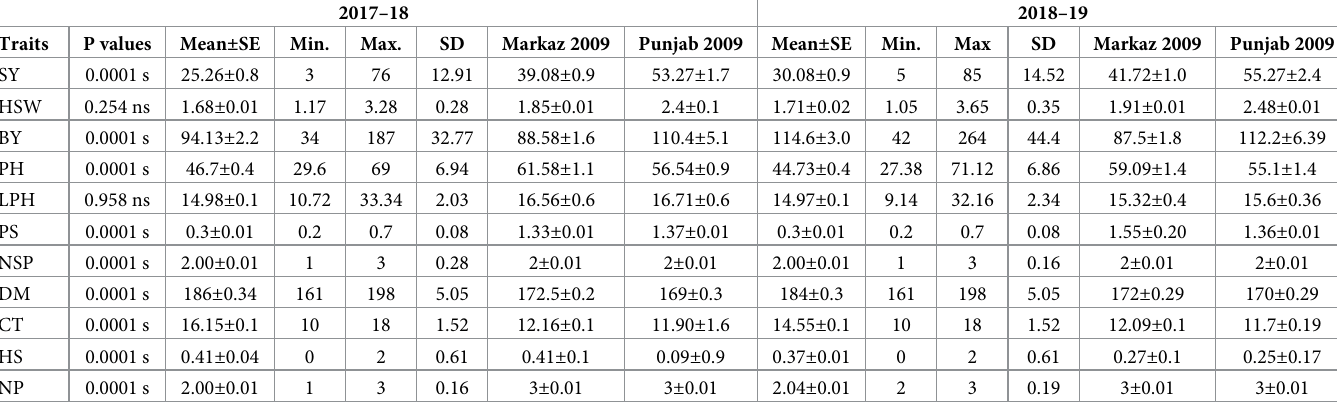
Table 1. Descriptive statistics for quantitative traits studied in lentil during 2017–18 and 2018–19.